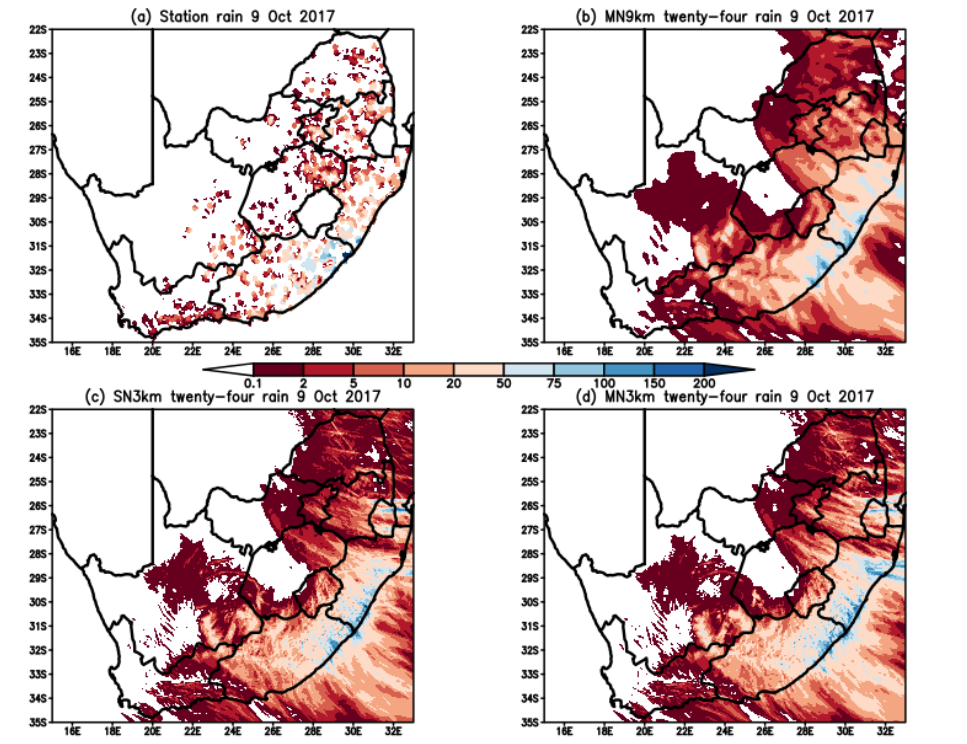
Figure 6. Observed twenty-four rainfall (mm) on ( a ) 9 October 2017 and CCAM simulated rainfall for ( b ) SN3km ( c ) MN3km and ( d ) MN9km, for the same